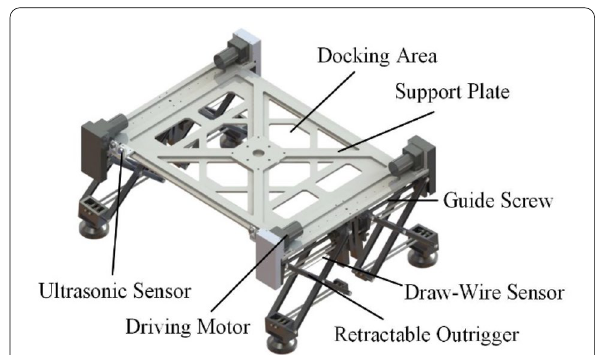
Figure 2 Schematic diagram of the lifting platform